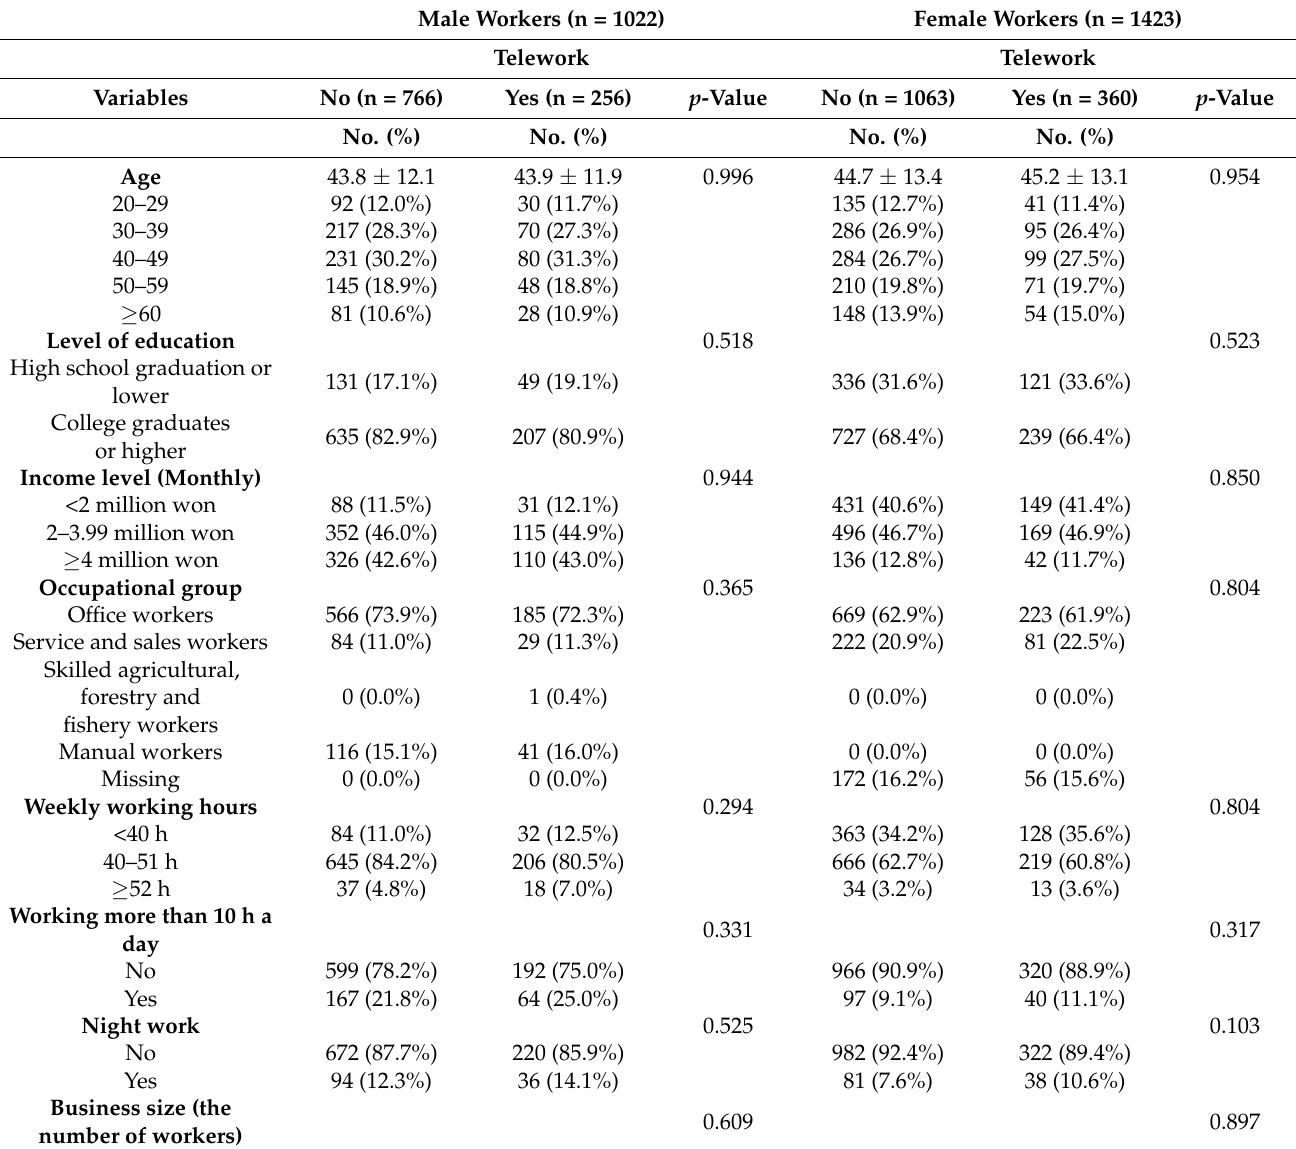
Table 2. Characteristics of male and female participants by telework after propensity score